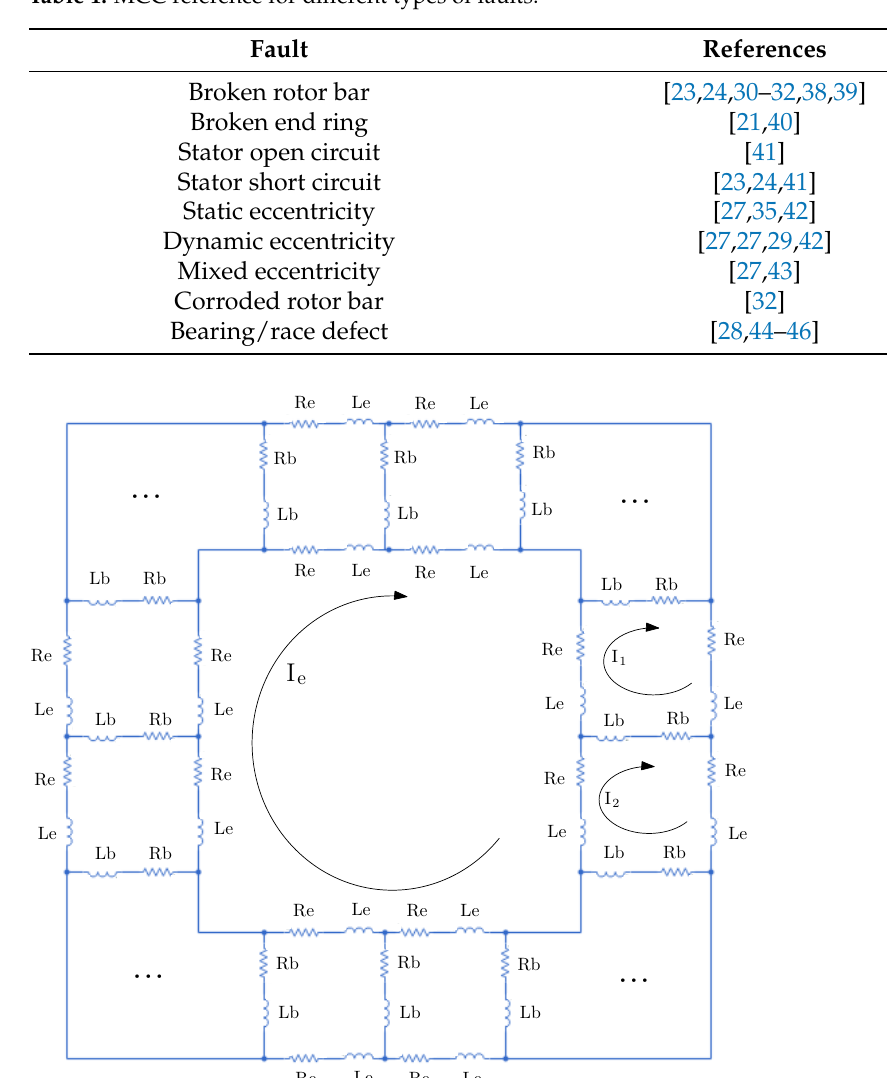
Figure 4. Multiple coupled circuit topology. Equivalent circuit of a rotor cage with multiple-coupled loops for healthy